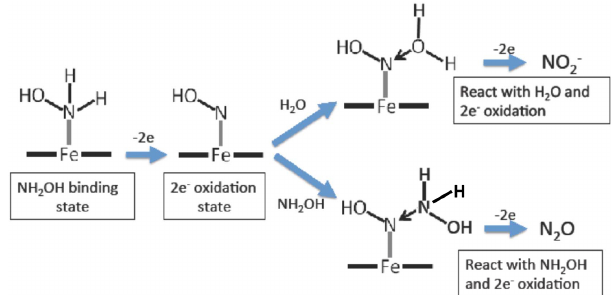
Figure 4. Two-step model of NH 2 OH oxidation catalyzed by